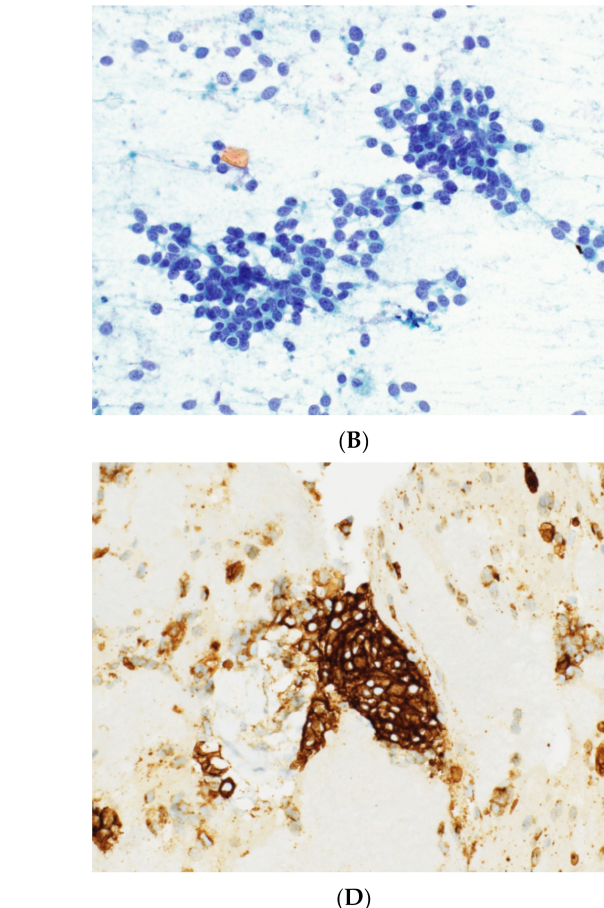
Figure 7. Thymic carcinoma. ( A ) Romanowsky and ( B ) Papanicalou stains of a thymic carcinoma aspirate show enlarged nucleoli with coarse chromatin. Neuroendocrine-like nuclear molding is seen. Magnification: 60 × and 40 × objectives. ( C ) The cell block shows positive staining for ( D ) CD117, supporting a diagnosis of thymic basaloid carcinoma. H&E and immunostain, 40 ×